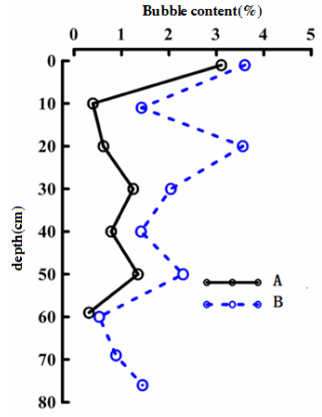
Figure 6. Bubble content distribution at Points A and